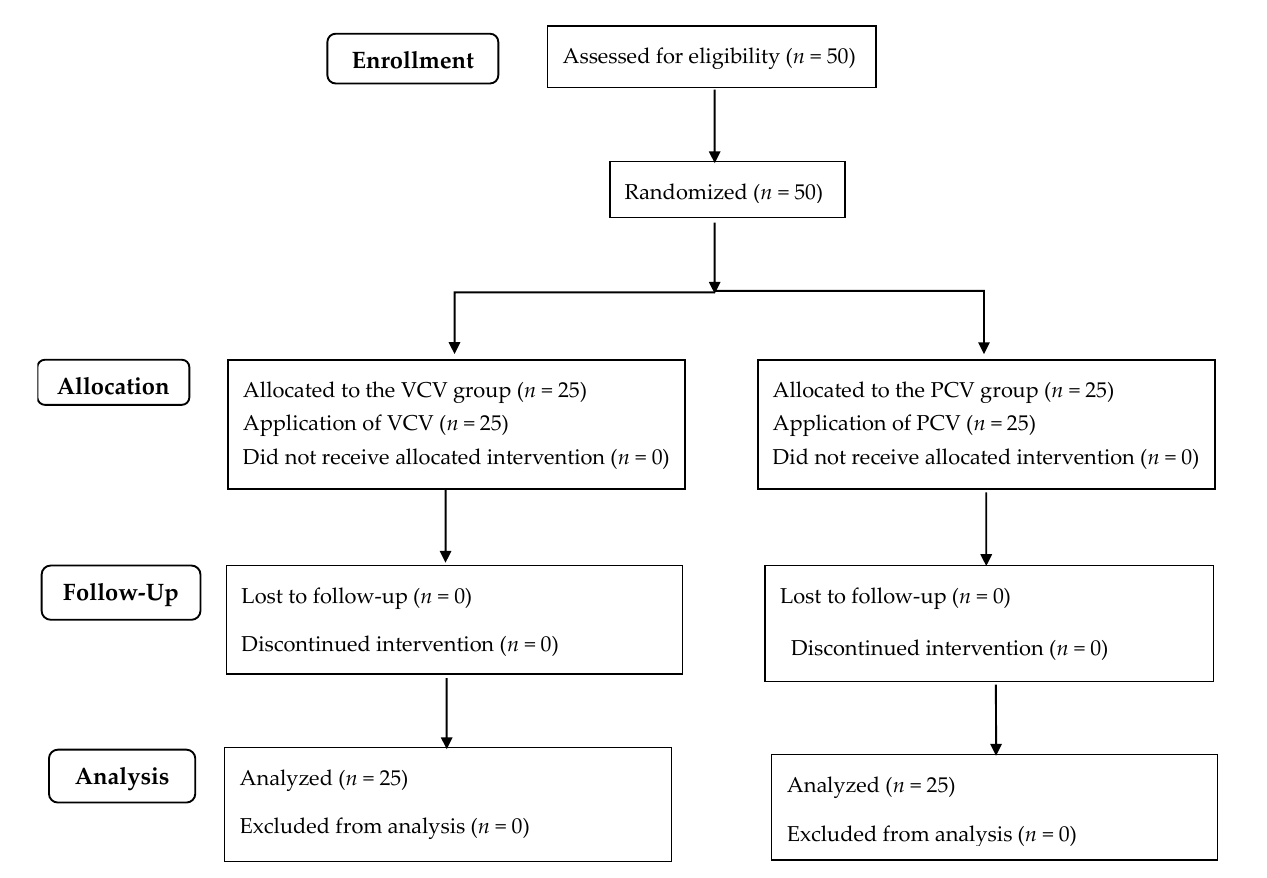
Figure 1. Flow diagram of patient’s allocation. VCV, volume-controlled ventilation; PCV, pressure- controlled ventilation-volume guarantee. Table 1. Patient characteristics and perioperative data.